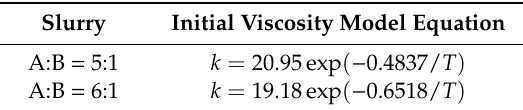
Table 4. The model equation of initial viscosity.